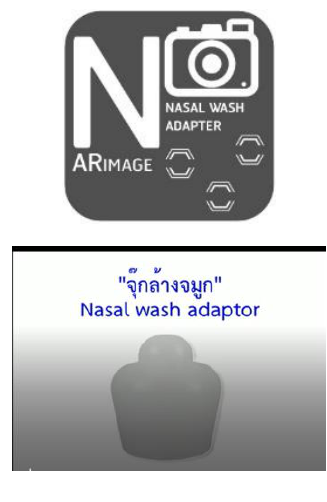
Figure 5 . Example of the nasal wash AR code for